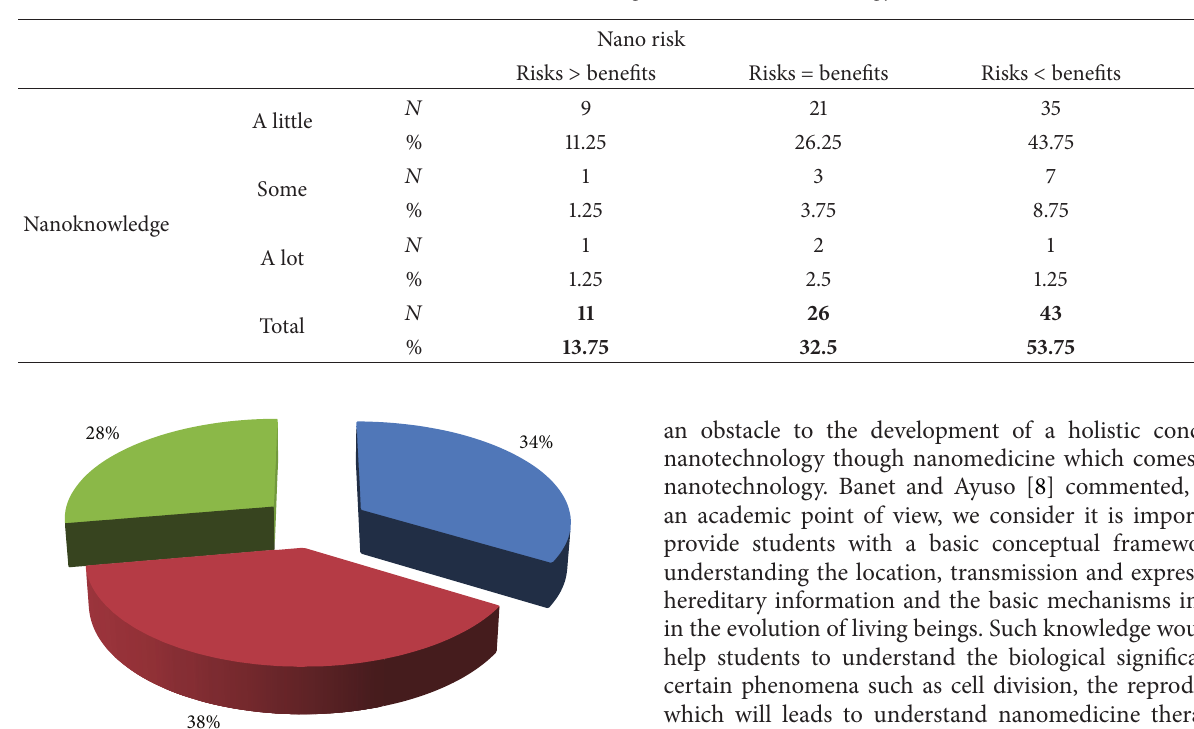
Table 2: Students’ knowledge of risks of nanotechnology.